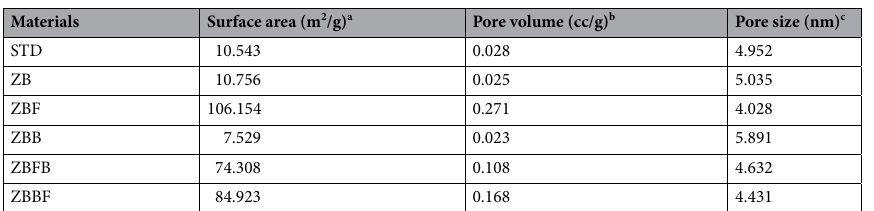
Table 1. The specific surface area, pore volume, and pore size of zeolite A standard (STD), zeolite A sugarcane bagasse fly ash powder (ZB), zeolite A sugarcane bagasse fly ash powder mixed iron(III) oxide-hydroxide (ZBF), zeolite A sugarcane bagasse fly ash beads (ZBB), zeolite A sugarcane bagasse fly ash powder mixed iron(III) oxide-hydroxide beads (ZBFB), and zeolite A sugarcane bagasse fly ash beads coated iron(III) oxide- hydroxide (ZBBF) by BET analysis. a MultiPoint BET. b Total pore volume for pore with Radius. c Average pore